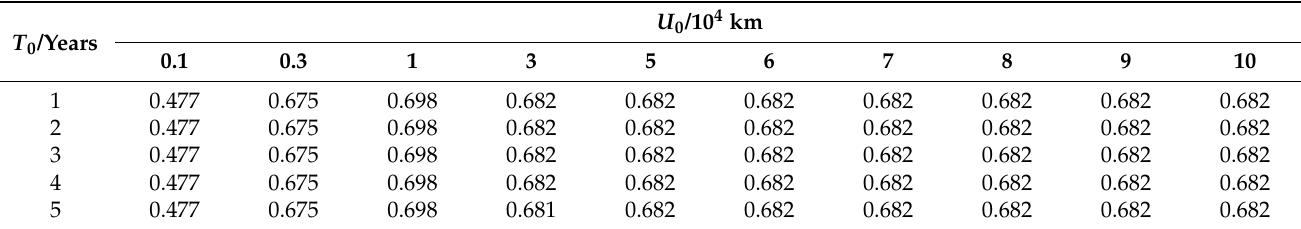
Table 5. Availability under different two-dimensional age replacement